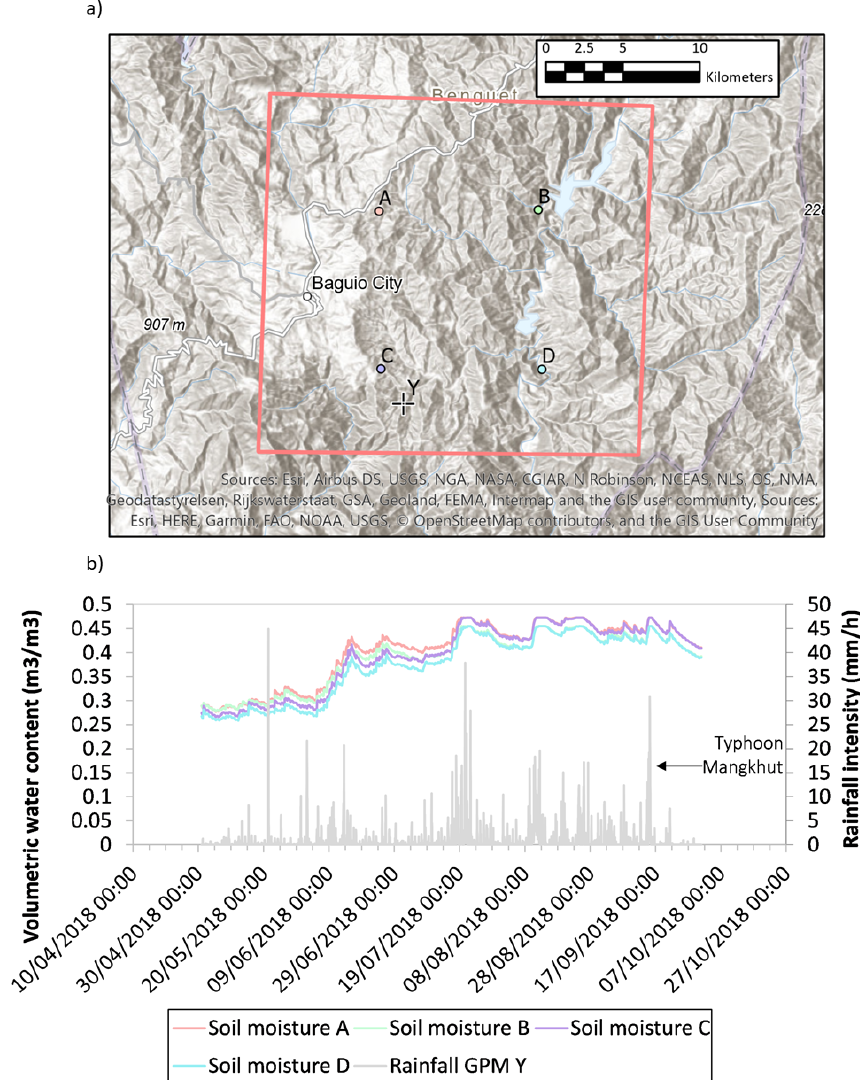
Figure 8. (a) Location of SMAP-L4 and GPM IMERG grid points from which the soil moisture and rainfall data have been obtained within the study area and (b) evolution of soil moisture (in volumetric water content) in A to D and rainfall in Y from the beginning of May to the end of September 2018. © OpenStreetMap contributors 2021. Distributed under a Creative Commons BY-SA